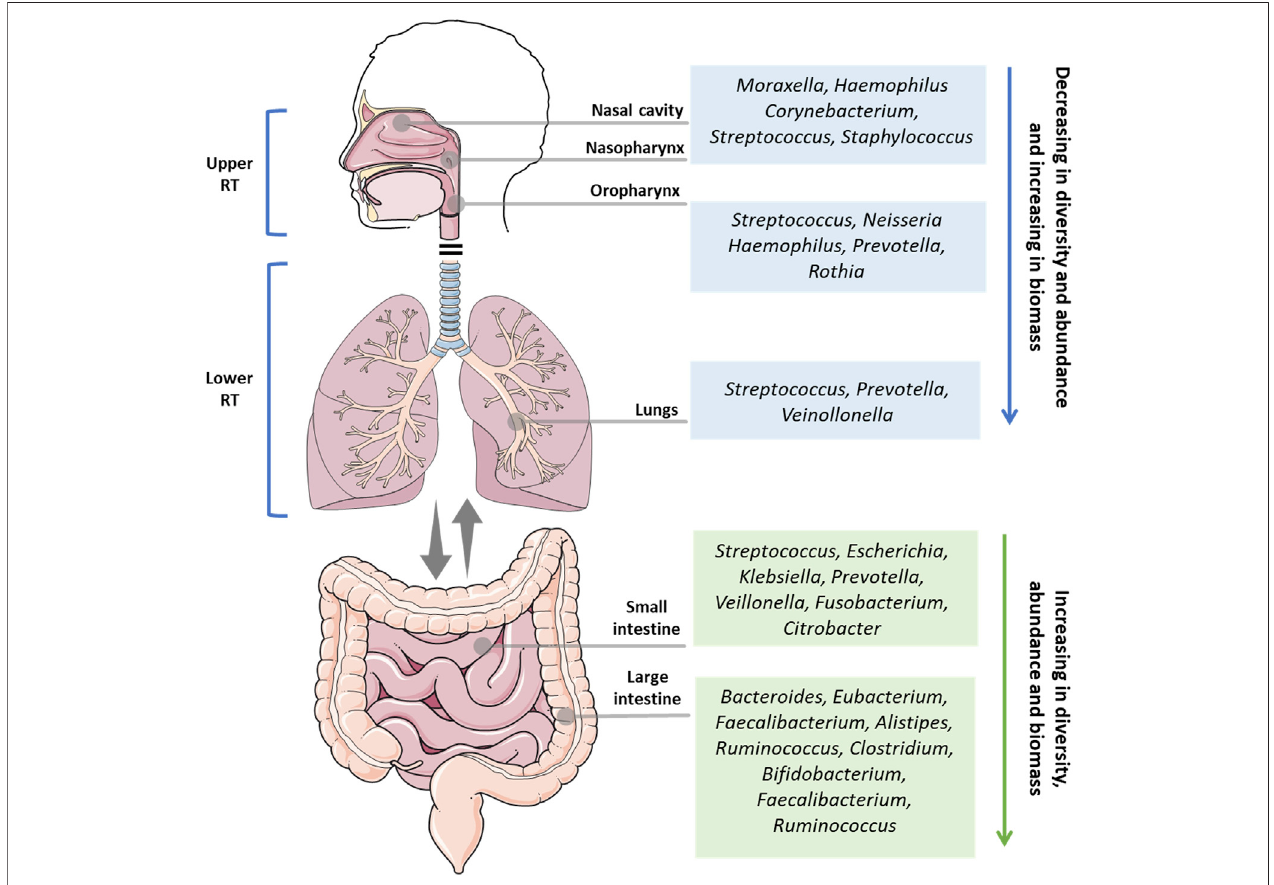
FIGURE1| Overviewofthemainmicrobialgenusin thehealthupper respiratory tract (nasalcavity, nasopharynx, oropharynx),lowerrespiratorytract (lungs), small intestine, and large intestine. RT: respiratory tract.